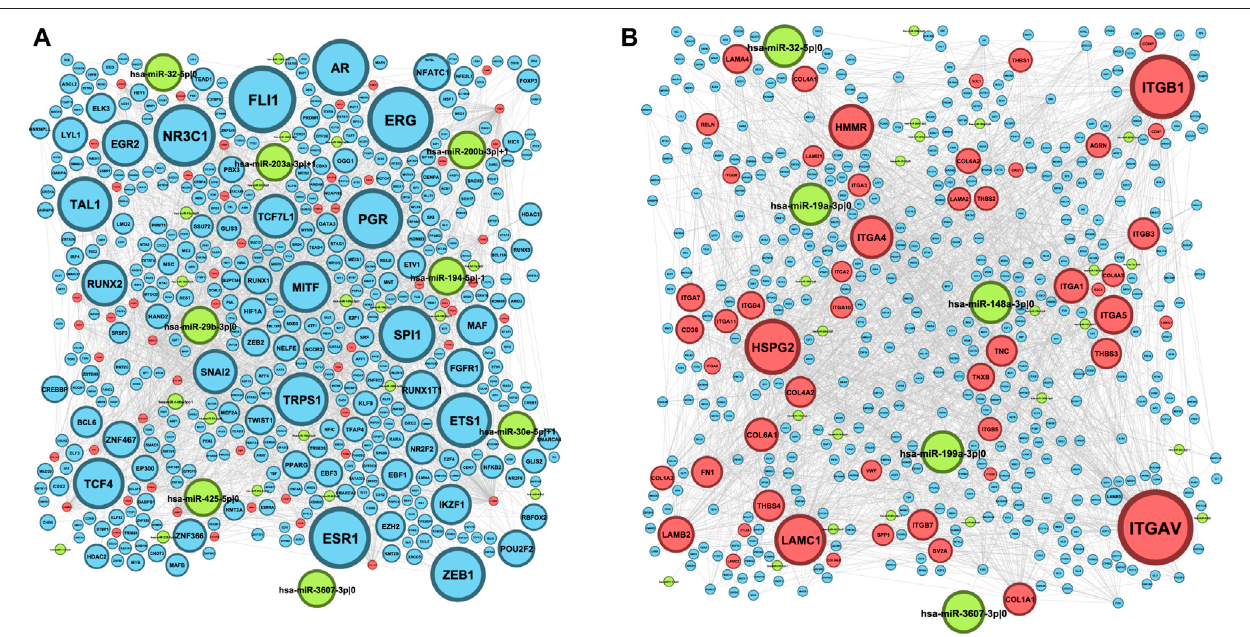
FIGURE 1 | ECM – receptor regulatory network. Blue nodes represent TFs, red nodes represent genes, and green nodes represent 5 ′ -isomiRs. The node size indicates the value of the node degree; (A) out-degree; (B) in-degree.